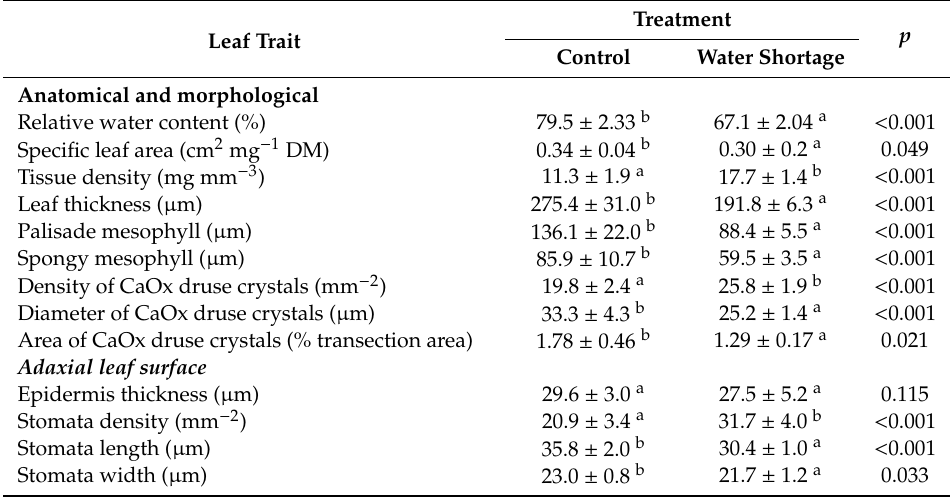
Table 1. Morphological, biochemical and physiological traits of the buckwheat leaves grown under the control and water shortage